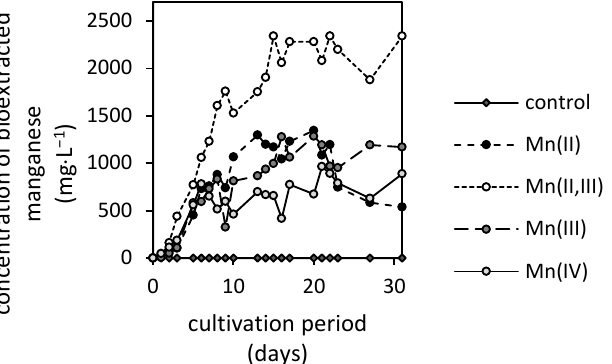
Figure 4. Concentrations of bioextracted manganese from its oxides (MnO, MnO · Mn 2 O 3 , Mn 2 O 3 and MnO 2 ) at different oxidation states during the static cultivation of microscopic filamentous fungus Aspergillus niger .